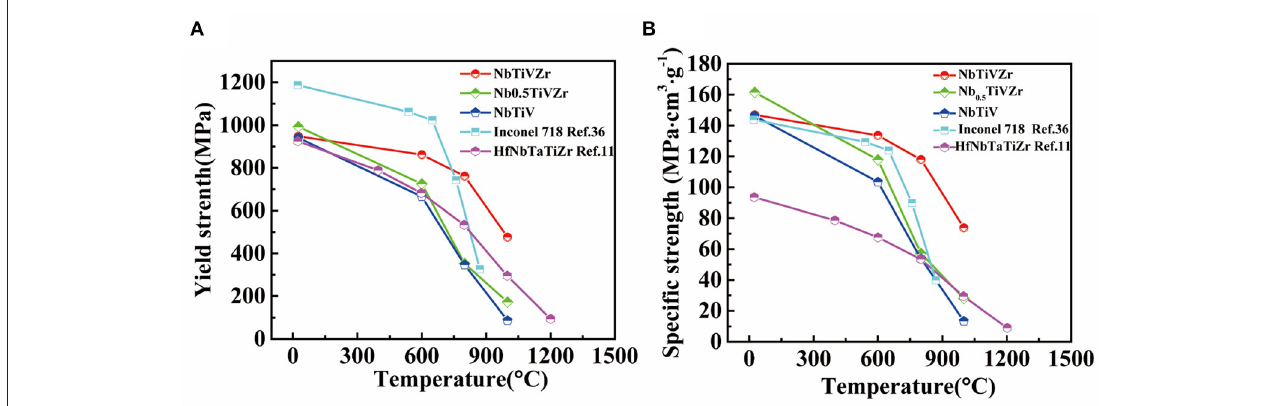
FIGURE 5 | Temperature dependence of yield strength and specific yield strength for NbTiVZr, Nb0.5TiVZr, and NbTiV alloys, Inconel 718, and HfNbTaTiZr HEA. (A) Elevated-temperature yield strength vs. temperature and (B) elevated-temperature specific yield strength vs.